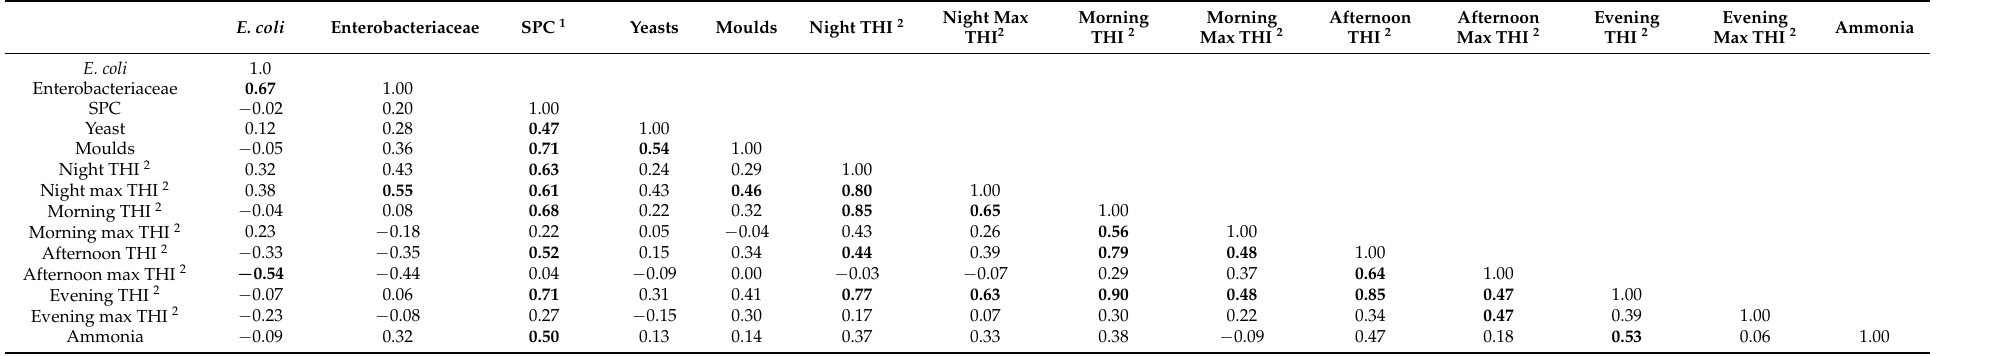
Table 4. Pearson’s correlation coefficients among variables related to air quality and microclimatic conditions in the calf